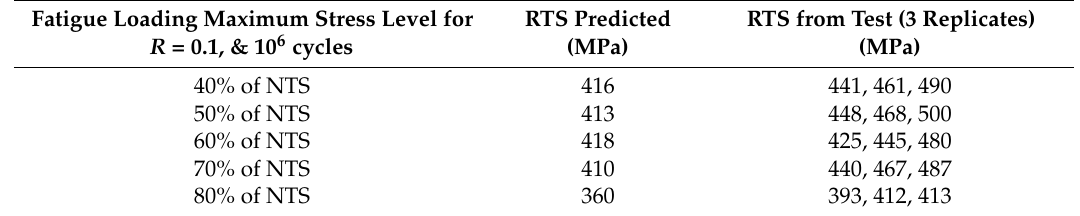
Table 5. Comparison of the residual strength of the Open Hole Tension (OHT) specimen with test data [34]. Fatigue Loading Maximum Stress Level